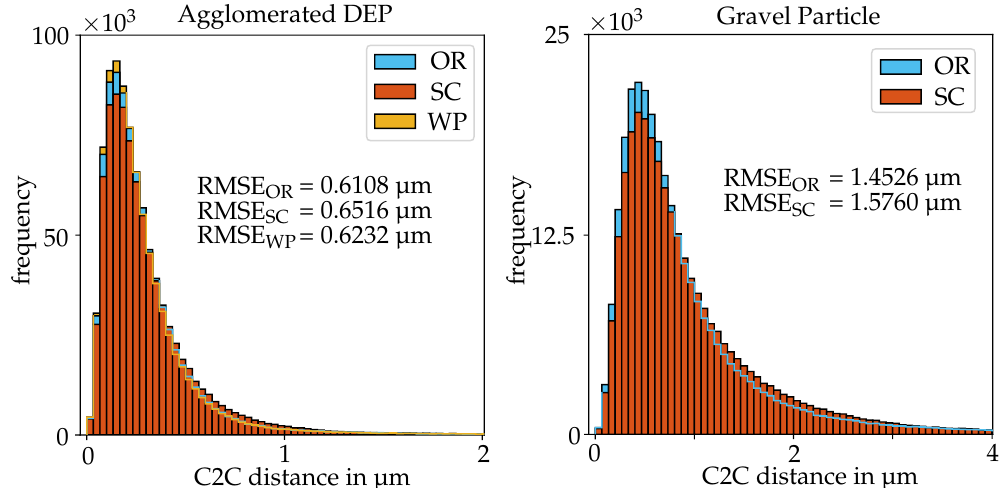
Figure 12. C2C distances between the aligned SEM reconstructions and confocal laser scanning microscope (CLSM) measurements for the respective factorization method regarding the sequences of the DEP agglomerate (1344742 points) and Gravel Particle (327997